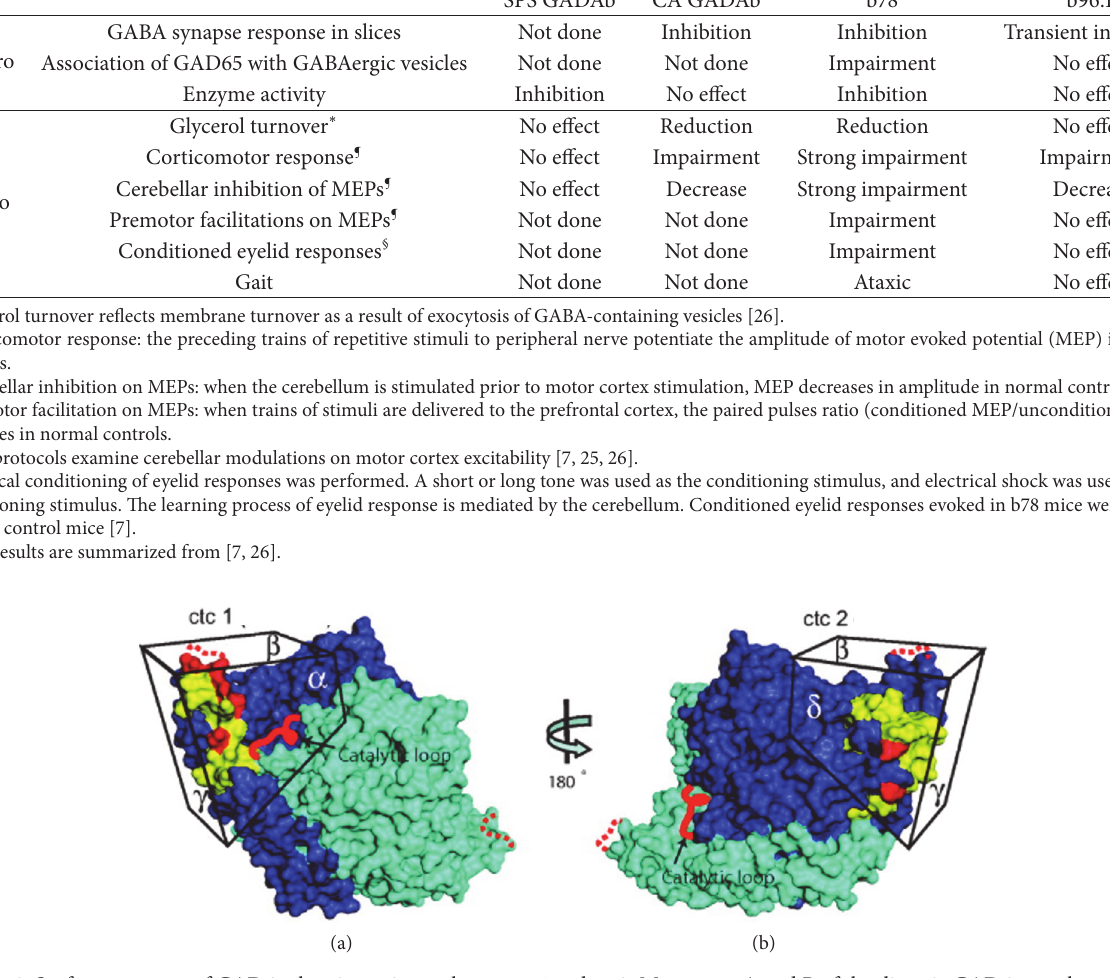
Figure 3: Surface structure of GAD65 showing epitope clusters ctc1 and ctc2. Monomers A and B of the dimeric GAD65 are shown in dark blue and cyan, respectively. Epitope clusters ctc1 and ctc2 on opposing faces of the C-terminal domains are shown. In (b), the molecule is rotated 180 ∘ along the vertical axis, and different faces of the C-terminal domain are shown as 𝛼 , 𝛽 , 𝛾 , and 𝛿 faces. Broad epitope locations are shown in yellow and single contact sites for mAb binding in red. The disordered catalytic loop and the COOH-terminal flexible loop are represented by red and red dotted lines, respectively. The epitope bound by GAD65Ab b78 resides primarily on the 𝛼 and 𝛽 faces of ctc1, while GAD65Ab b96.11 recognizes an epitope located on the 𝛿 and 𝛾 faces of ctc2. This figure was adapted from Fenalti et al. (2008) with permission